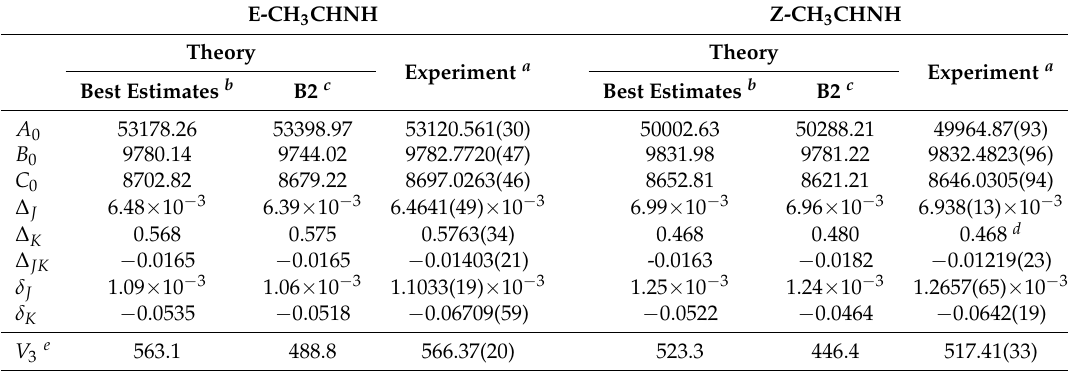
Table 4. Computed and experimental rotational parameters (values in MHz) of